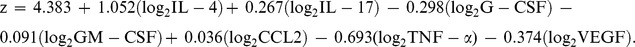
Cumulative incidence of cryptococcal IRIS.The data are based on a weighed predictive biomarker score composed of pre-ART serum levels of seven biomarkers—IL-4, IL-17, G-CSF, GM-CSF, CCL2 (MCP-1), TNF-α, and VEGF—calculated as follows. Probability of IRIS =  where:Probability risk is scored from 0 to 1.0 with the categorical classification being defined for low risk (0–0.40), moderate risk (0.41–0.60), and high risk (0.61–1.0). The performance as quantified by the AUC is 0.82 for correct prediction (i.e. C-statistic).